Question: Describe this figure in one sentence.
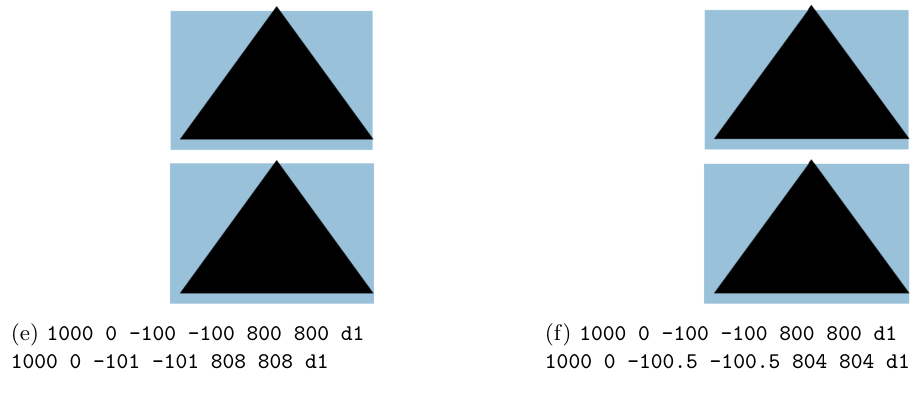
Answer: d1 Operator - control, 10%, 5%, 2%, 1%, 0.5% (1-2%)